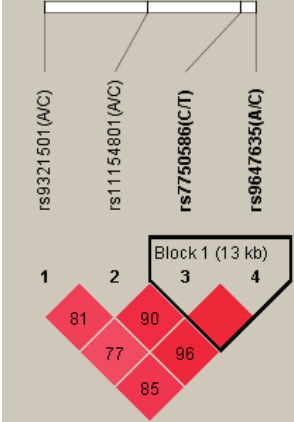
Figure 1. Linkage disequilibrium (LD) plot. The D' values among the SNPs investigated are